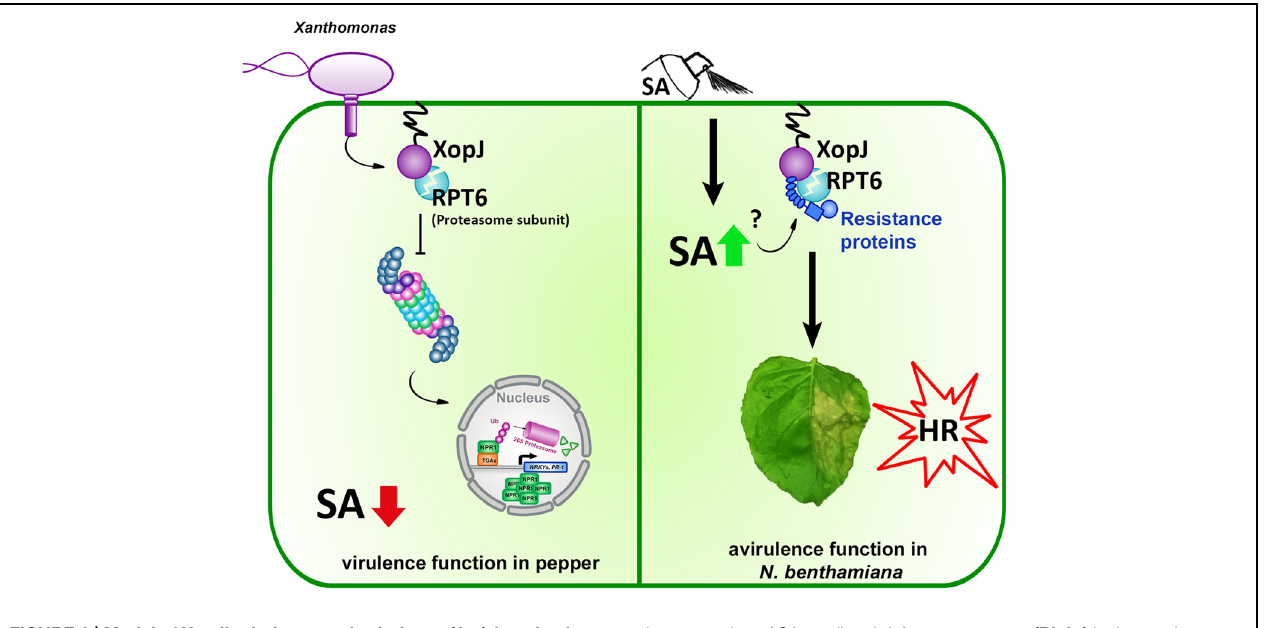
the attenuation of SA-mediated defense responses. (Right) In the non-host plant N. benthamiana transiently expressed XopJ cleaves endogenous RPT6. When SA levels are increased by exogenous application of the defense hormone, R-protein mediated recognition of RPT6 cleavage by XopJ is activated leading to the induction of HR-like